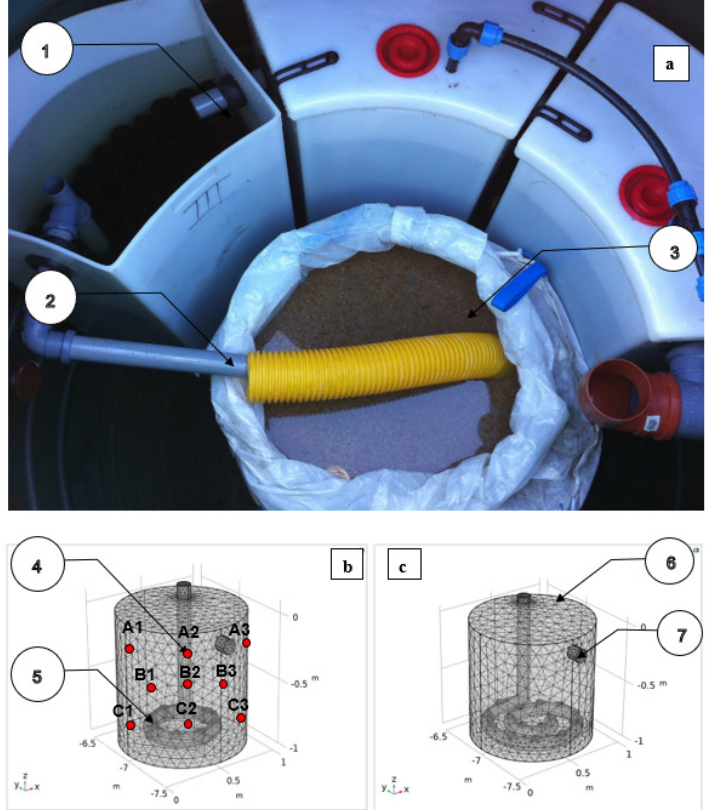
Figure 1. ( a ) View of the package treatment plant with the phosphorus (P) filter bag in the middle and ( b , c ) the modelled system. The system consists of: (1) biofilter tank; (2) inlet pipe receiving wastewater from the biofilter tank; (3) reactive medium; (4) observation points; (5) perforated distribution pipe; (6) reactive filter bed domain; and (7) outlet pipe. There are observation points at the top (0.25 m depth; A1–A3), middle (0.50 m depth; B1–B3) and bottom (0.75 m depth; C1–C3).